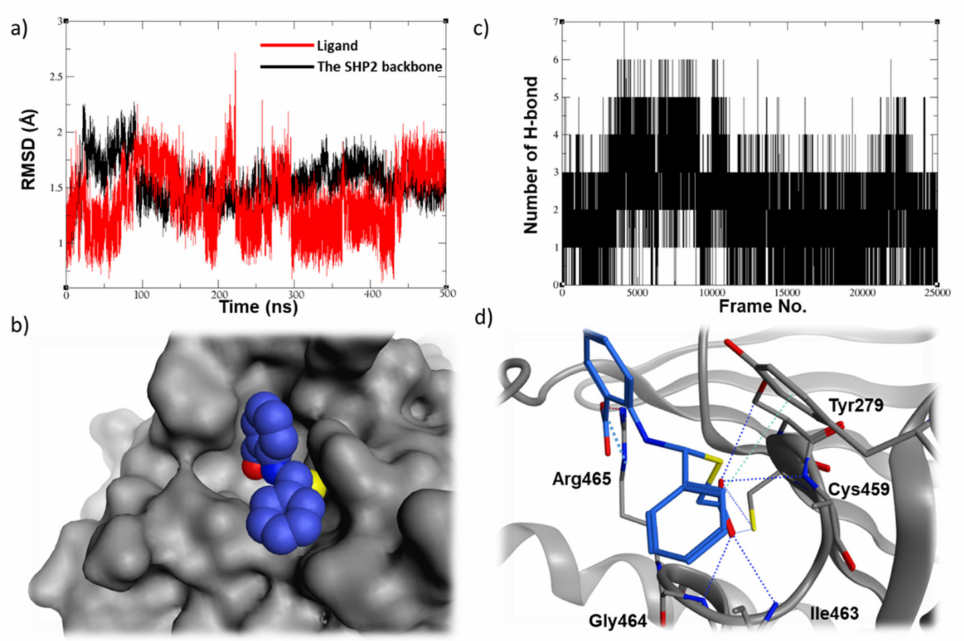
Figure 6. ( a ) The RMSD plot of the 500 ns MD simulations of compound 24198 along with ( b ) the hydrogen bonding plot, ( c ) the top-cluster conformation filling (blue spheres) in the SHP2 active site (gray surface), and ( d ) the ligand 3D binding mode showing the key interactions made with the surrounding